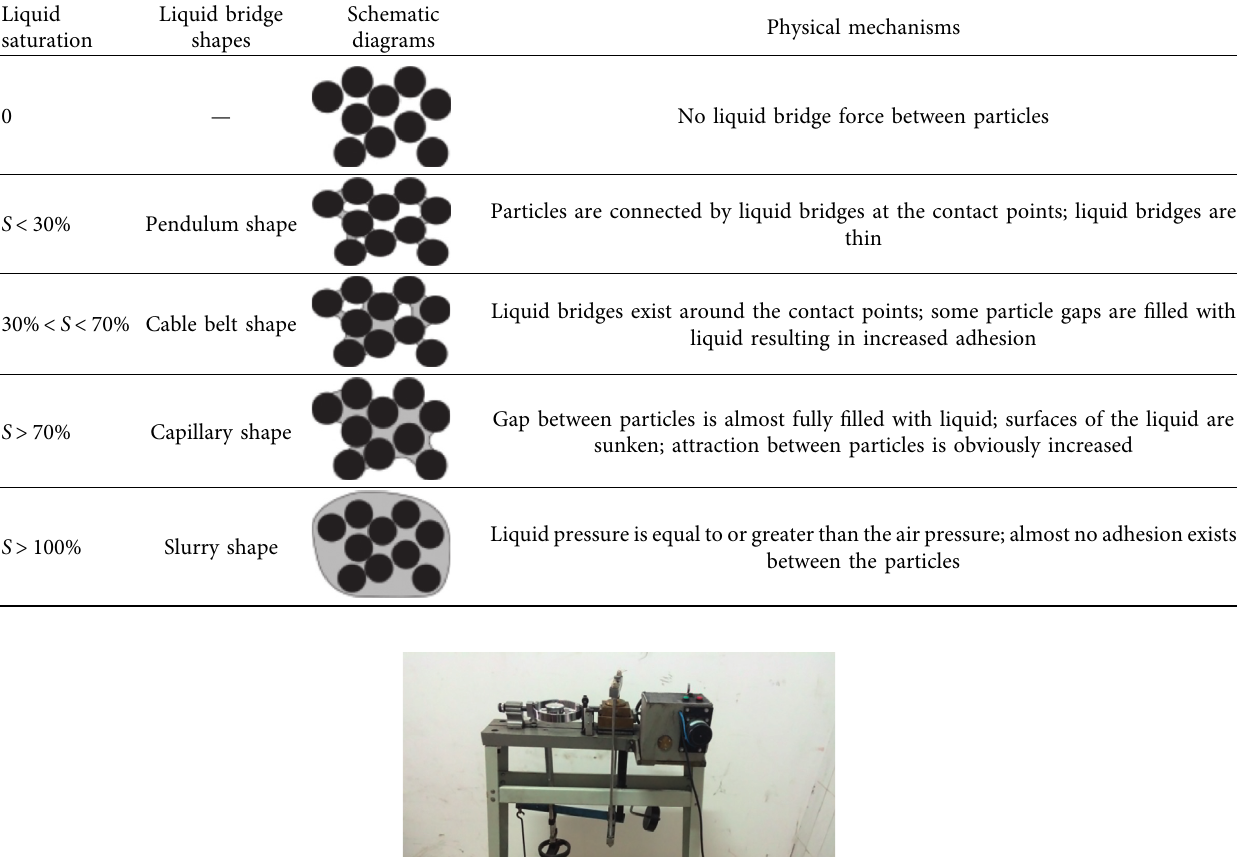
Table 4: Liquid saturation in the gaps between particles and the corresponding liquid bridge